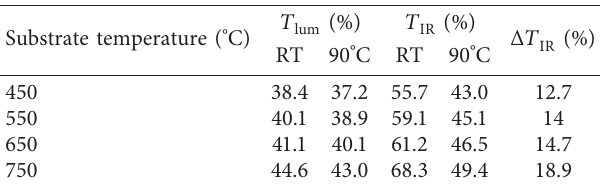
2 (M) films grown at different temperatures. Table 2: Optical properties of the PLD VO